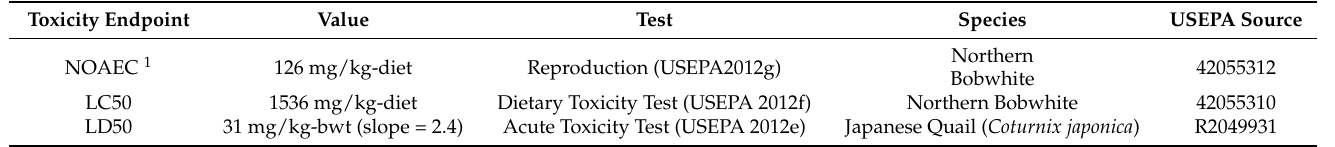
Table 2. Representative avian toxicity test results for birds exposed to